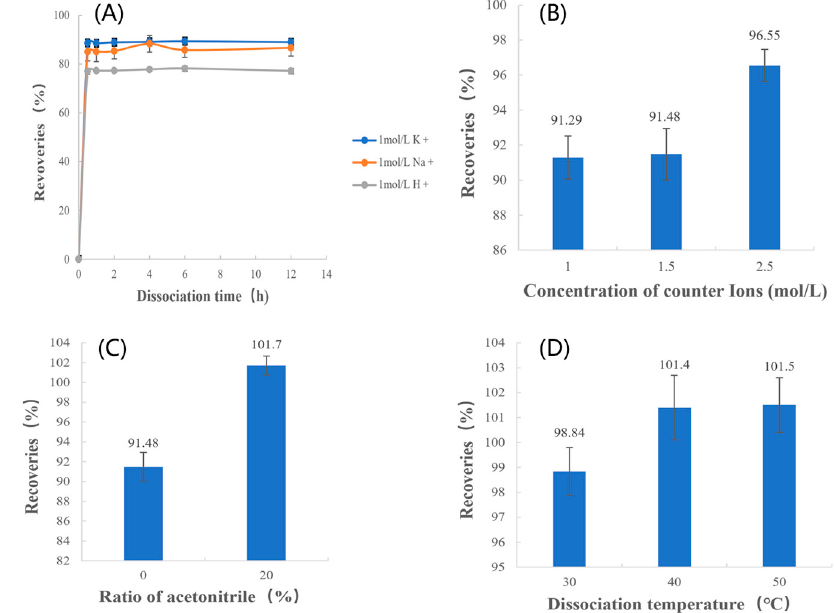
Figure 5. Recoveries of ( A ) type of counterions, ( B ) concentration of counterions, ( C ) ratio of acetonitrile, and ( D ) dissociation temperature. Table 5. Statistical analysis of factors influencing the dissociation